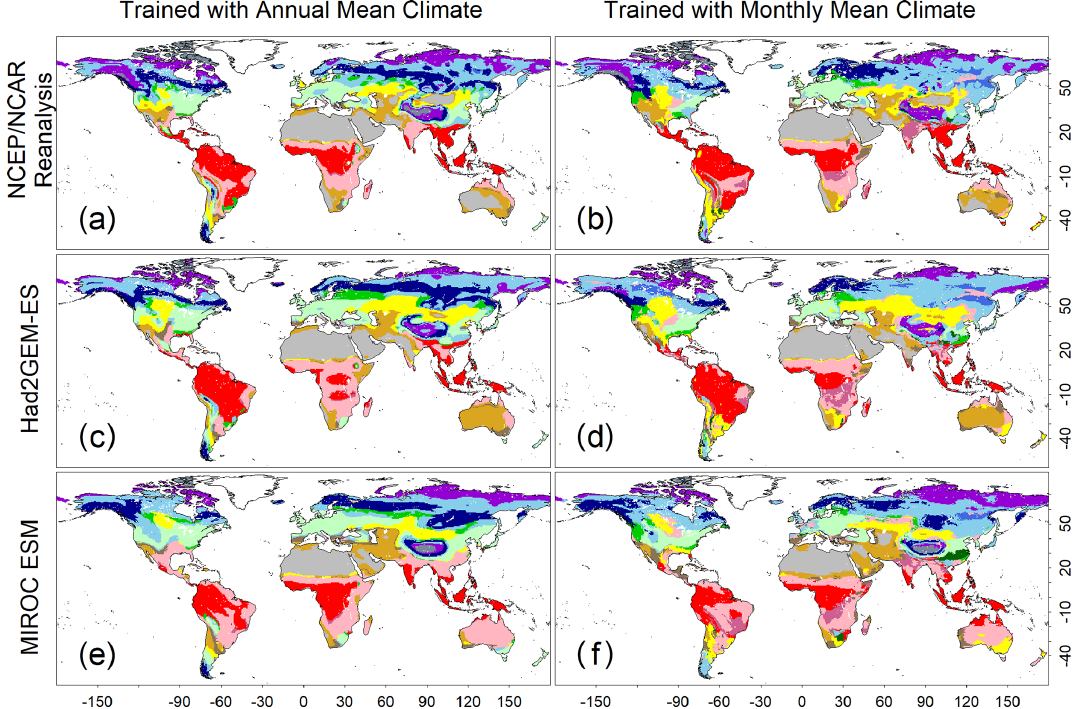
Figure 3. Test accuracies representing how the trained CNN models simulate a biome map with climatic conditions spanning from 1971 to 1980. (a, c, e) Biome map generated by the CNN model that was trained with annual mean climate images from the CRU dataset. (b, d, f) Biome map generated by the CNN model that was trained by monthly mean climate images from the CRU dataset. Three climatic datasets, which were not involved during the training process, were employed to generate these maps. (a, b) NCEP/NCAR reanalysis data; (c, d) output of the Had2GEM-ES dataset; and (e, f) output of the MIROC-ESM dataset. Colour definitions are available in Fig.